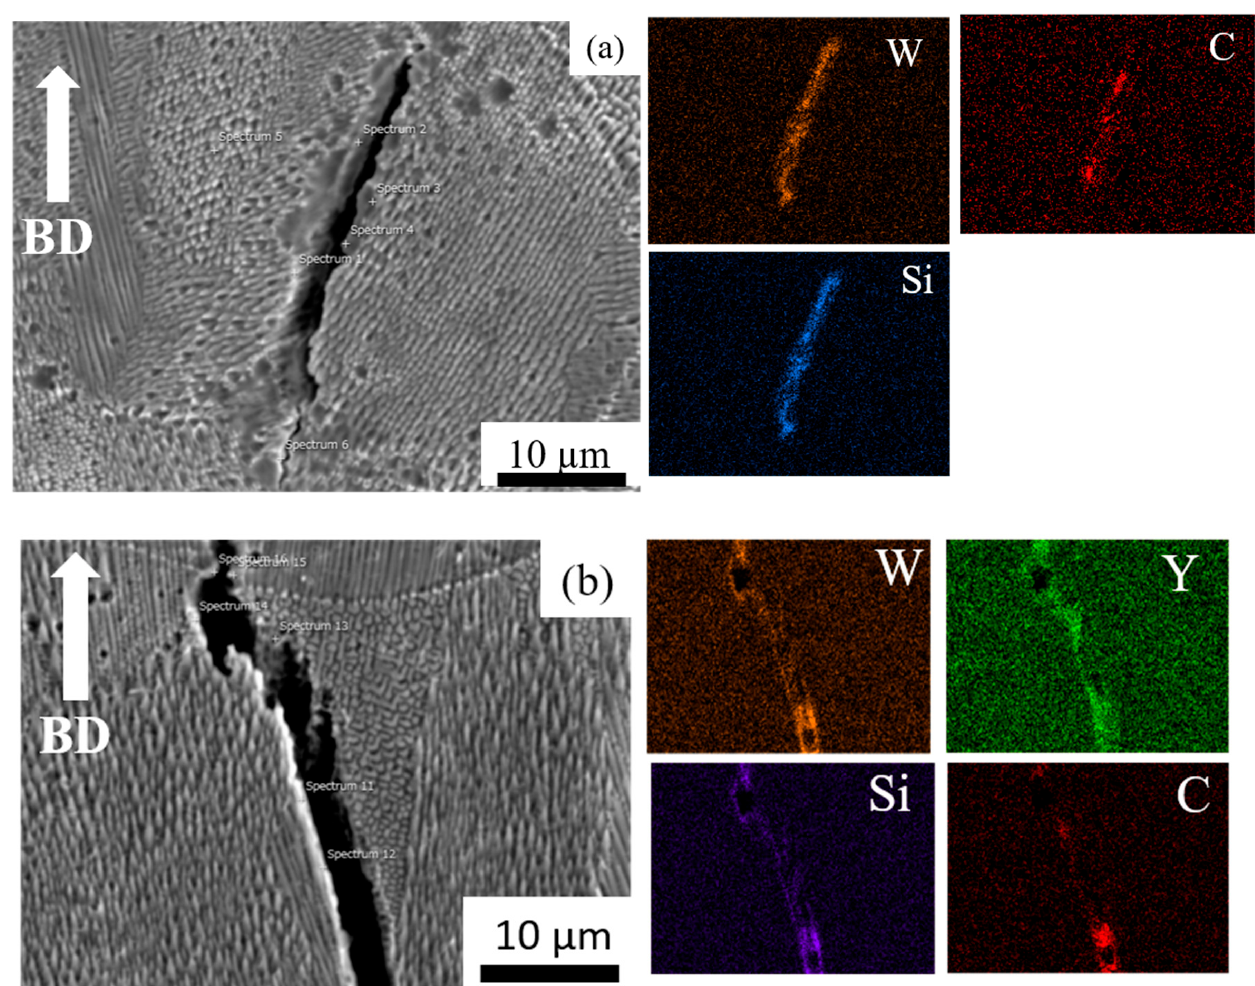
Figure 3. Energy Dispersive X-ray Spectroscopy (EDS or EDX) analysis of ( a ) as-built HX and ( b ) as-built HX-a specimens near the crack.